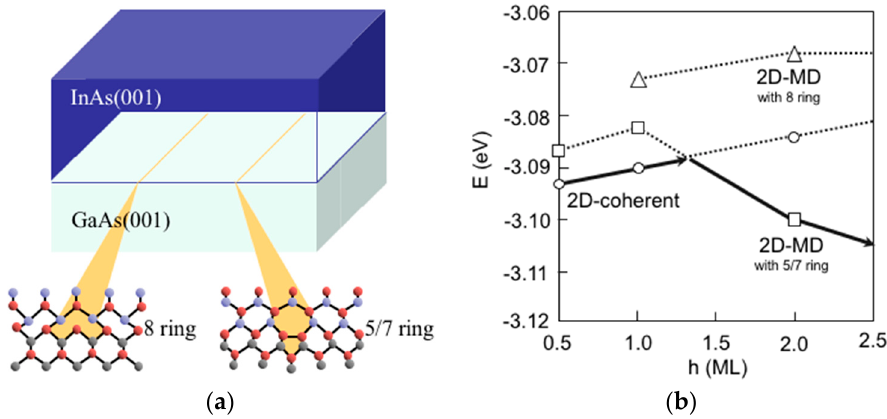
Figure 11. ( a ) Schematic of the 2D growth with dislocation (8-ring core and 5/7-ring core) formation at the interface; ( b ) Calculated energy for the 2D coherent growth (2D-coherent) and the 2D growth with MD (2D-MD with 8-ring and 2D-MD with 5/7-ring) as a function of layer thickness h.